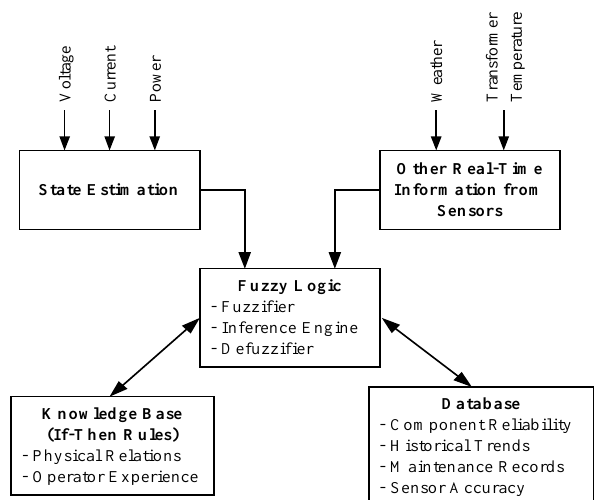
Figure 9 . Hybrid Fuzzy Classifier System